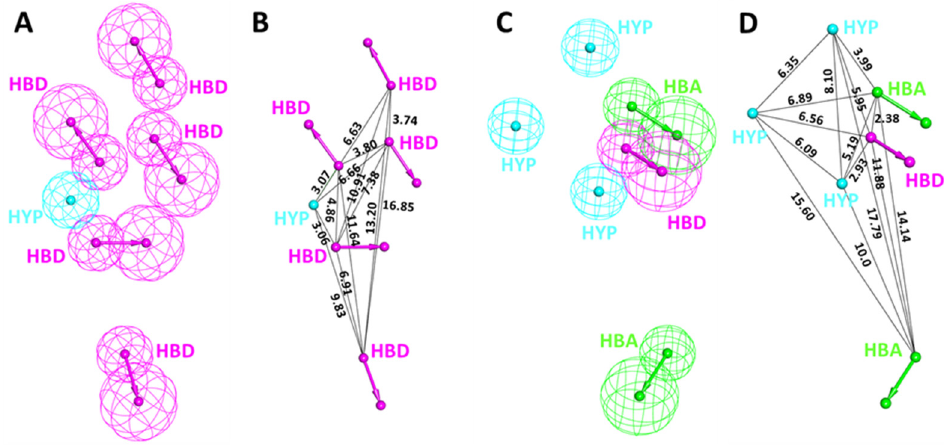
Figure 4. The selected pharmacophore models from the ( A ) ligand-based and ( C ) structure-based approach with the ( B , D ) interfeature distance between individual features of both models, respectively.